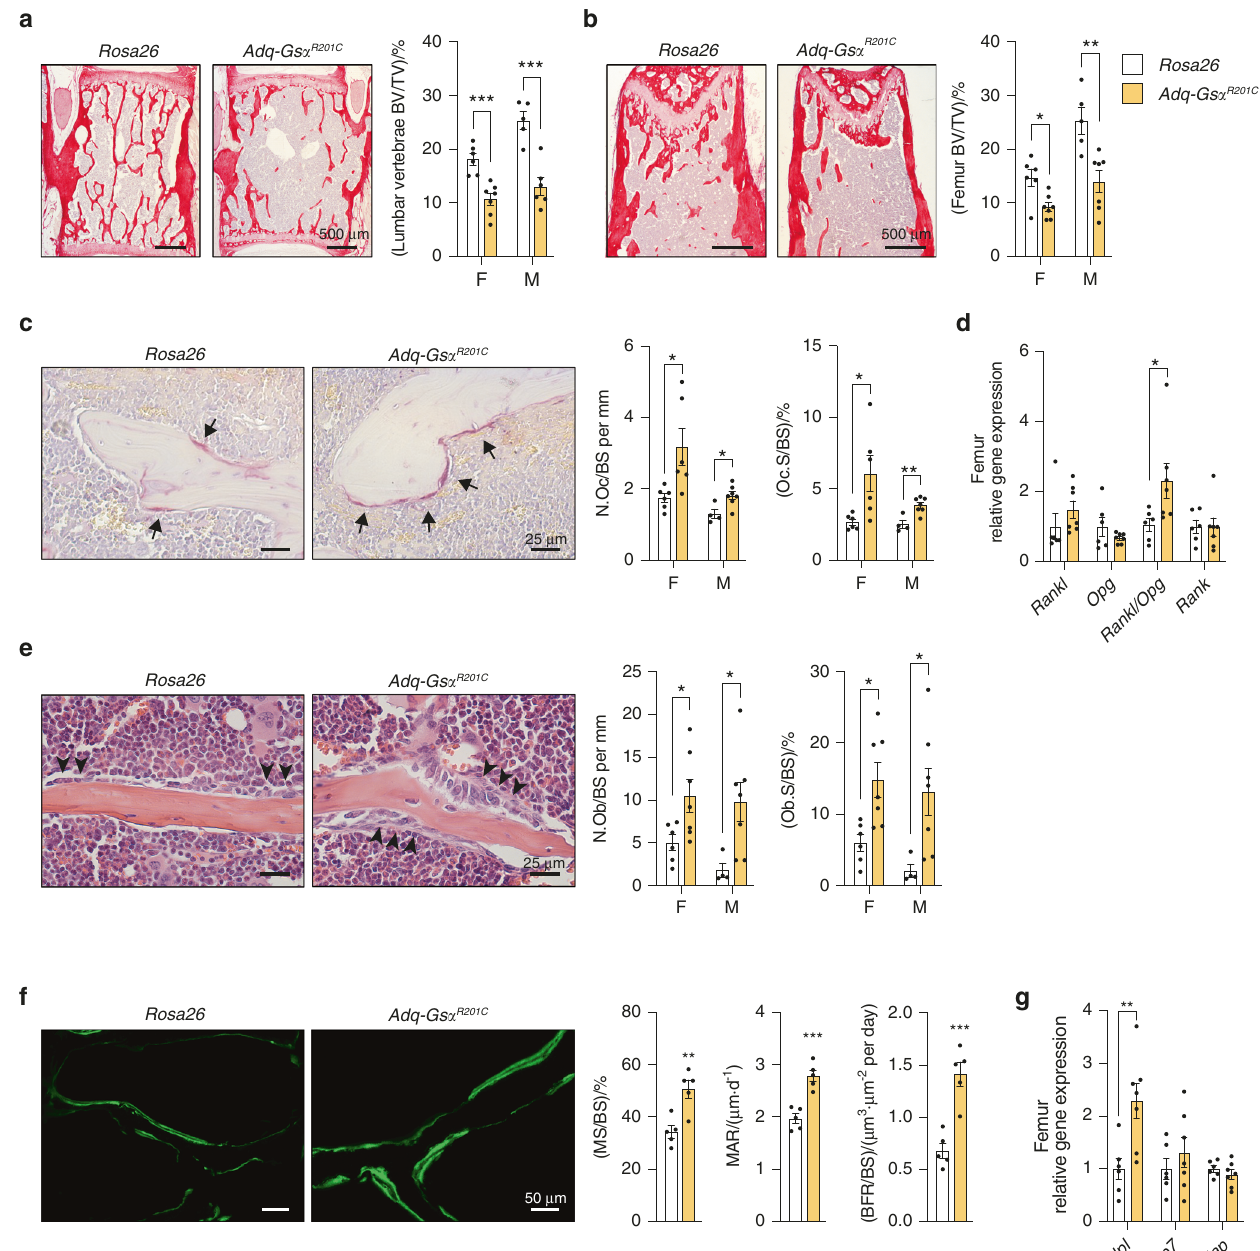
Fig. 2 Enhanced trabecular bone resorption in 3-month-old Adq - Gs α R201C mice. a , b Representative histological pictures from Sirius red- stained sections and histomorphometric analysis of trabecular bone of lumbar vertebrae ( a ) and femora ( b ). BV/TV: bone volume per tissue volume. c TRAP histochemistry highlighting cells of the osteoclastic lineage ( arrow ) and histomorphometry of osteoclast parameters. N.Oc/BS: number of osteoclasts per bone surface. Oc.S/BS: osteoclast surface per bone surface. d Relative gene expression of Rankl , Opg, Rankl/Opg ratio and Rank in femora from female mice. e Representative images from H&E-stained sections showing osteoblasts ( arrowhead ) and histomorphometry of osteoblast parameters. N.Ob/BS: number of osteoblasts per bone surface. Ob.S/BS: osteoblast surface per bone surface. f Representative pictures of calcein labeling in trabecular bone of female mice and dynamic histomorphometry for bone formation parameters. MS/BS: mineralizing surface per bone surface. MAR: mineral apposition rate. BFR/BS: bone formation rate. g Relative gene expression of Alpl , Sp7 and Bglap in femora from female mice. F Females. M Males. Data are presented as mean ± SEM. Statistical analysis was performed using Student t-test; * P < 0.05, ** P < 0.01, *** P < along the blood vessel wall to extensively fi ll the marrow space in female mice (Fig. S5a). Bone deposition started within 3 months of old animals (Figs. 5a, b, S5a-c). The bone tissue had a mixed woven age in the diaphyseal region at the tibia/ fi bula junction, and, as and lamellar structure (Fig. 5b), showed a thin layer of osteoid, clearly shown by micro-CT scans, it involved the cortical endosteum and was well mineralized (Fig. 5c). In Adq-mTmG;Gs α R201C female only focally (Fig. 5a), especially at sites in which large blood vessels entered the marrow cavity (Fig. 5b). Bone formation continued reporter mice the expression of GFP was detected in the vast